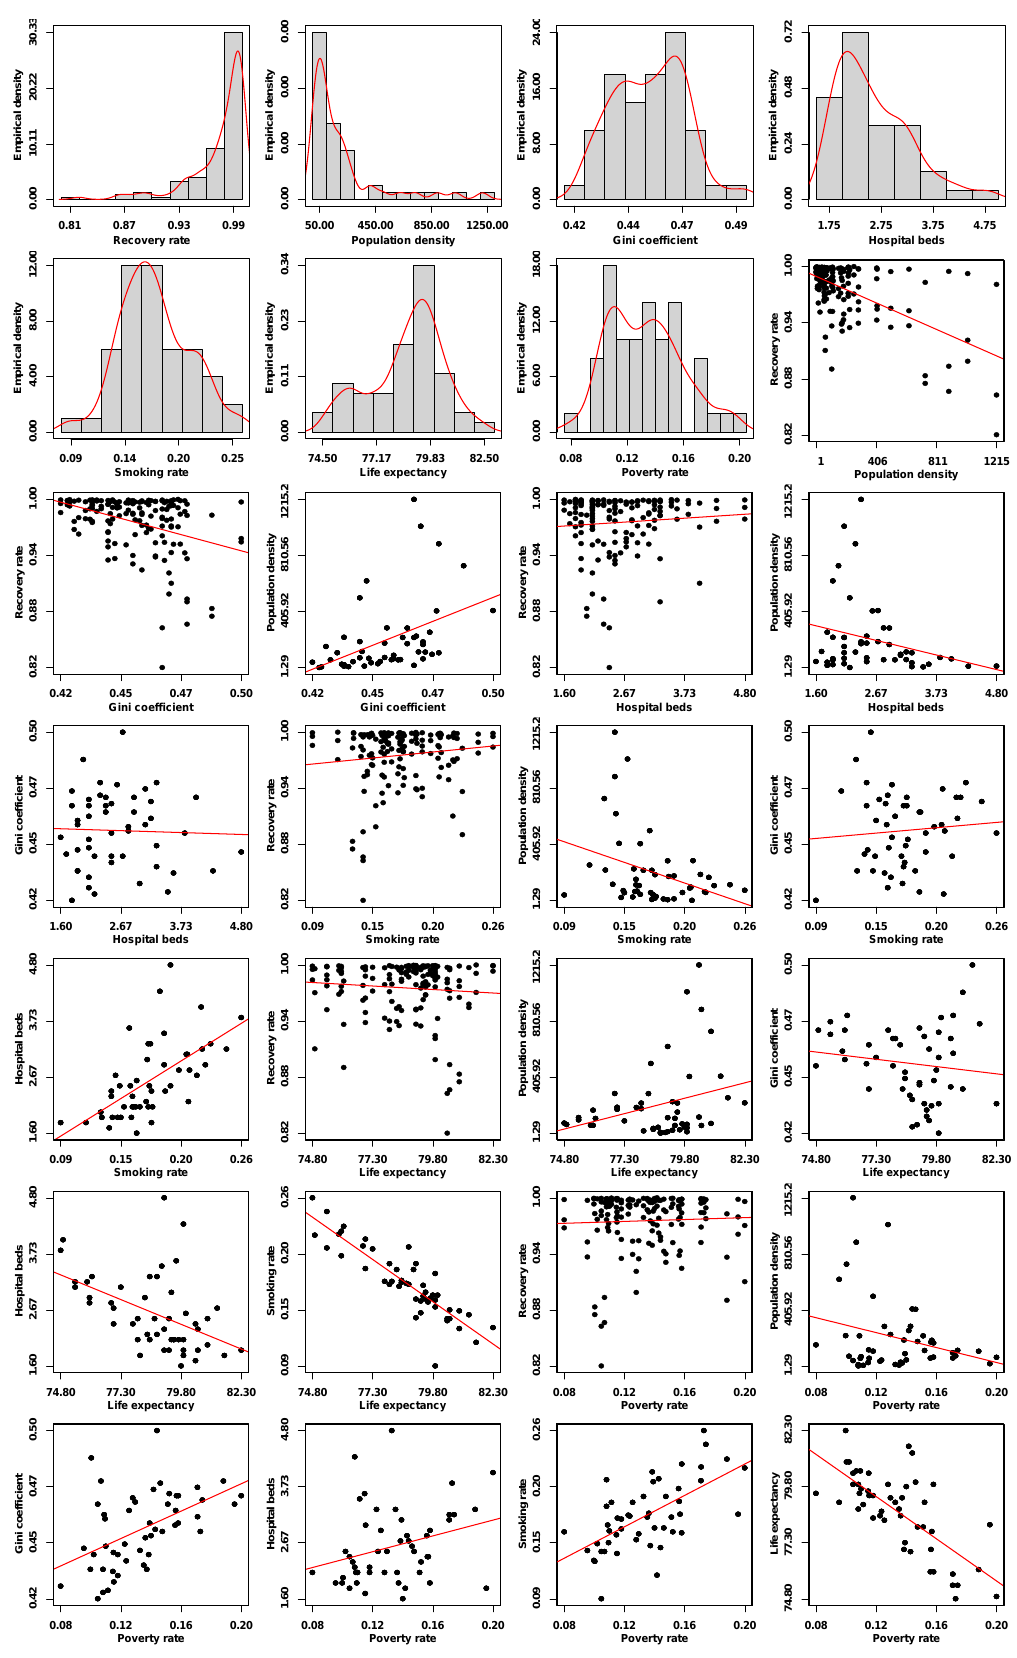
Figure 6. Scatterplots and histograms about the COVID-19 data